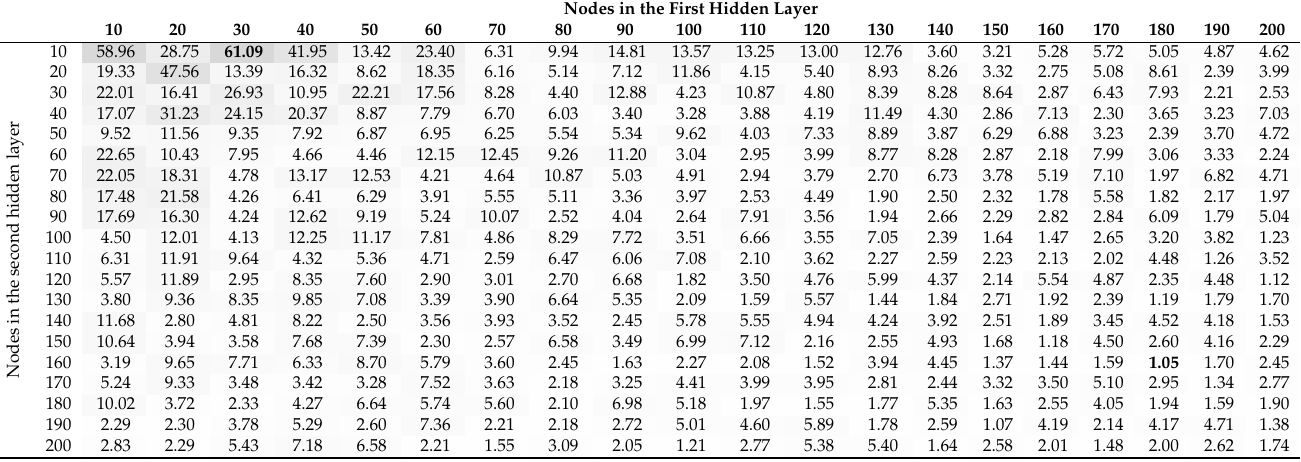
Table A2. Standard deviation of the predictive error (%) for each topology as a function of the amount of nodes in the hidden layers.